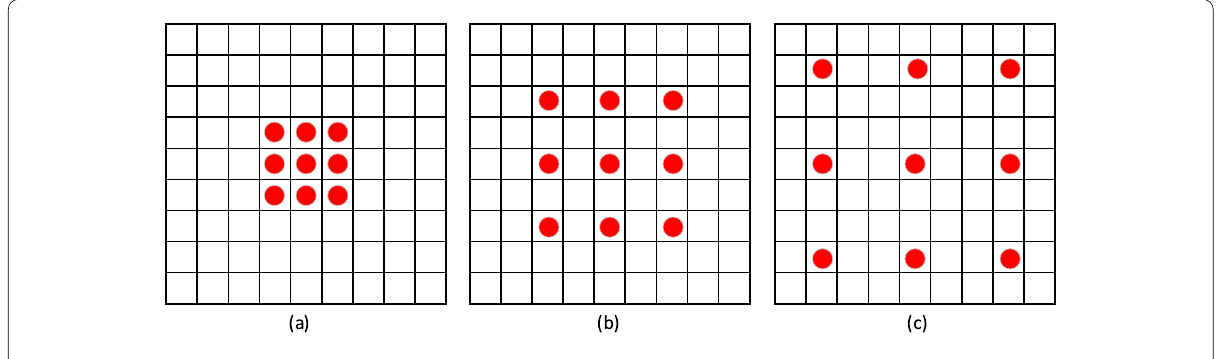
Figure 4 Comparison between ordinary convolution and dilated